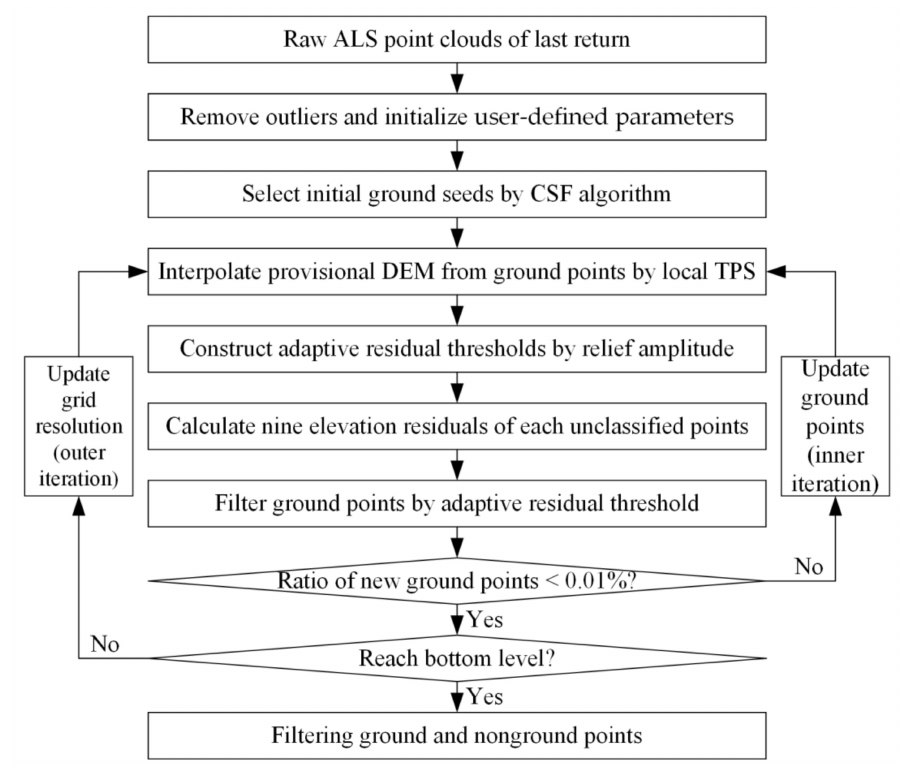
Figure 4. Flow chart of the proposed ASI filter.